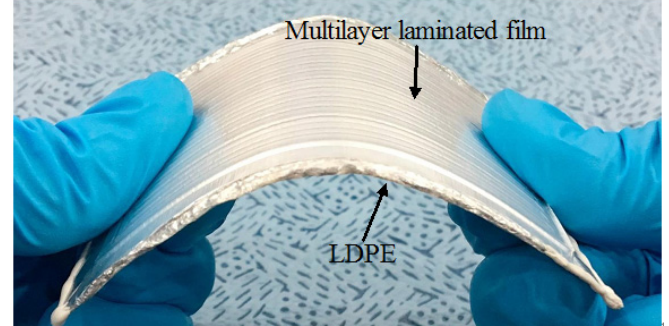
Figure 15. Flexible OHP [148]. Lim et al. (2018).